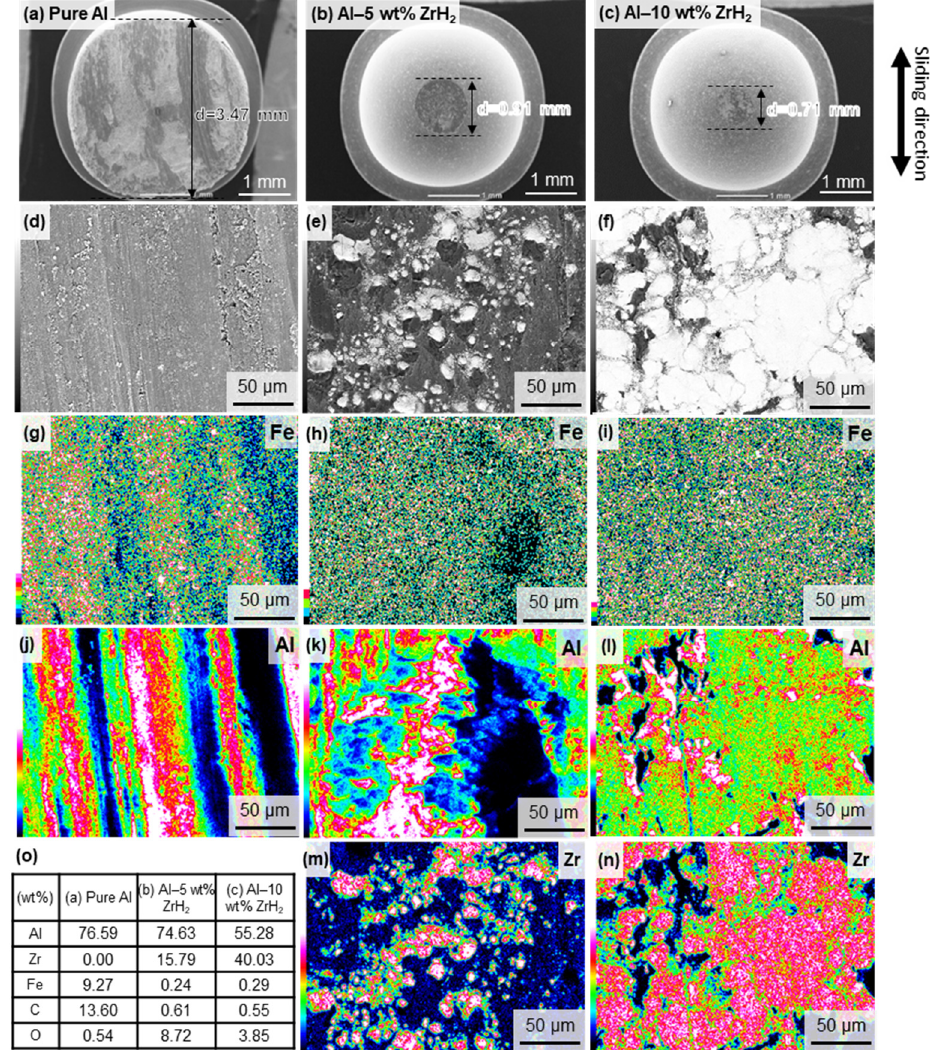
Figure 8. SEM–EDS analysis on the wear surface of ( a ) pure Al, ( b ) Al–5 wt% ZrH 2 , and ( c ) Al–10 wt% ZrH 2 pin specimen under an applied load of 4.9 N. ( d – f ) High magnification images of ( a – c ). ( g – n ) The corresponding Fe, Al, and Zr elements distribution maps in ( g – i ). ( o ) The quantitative EDS analysis results of ( a – c